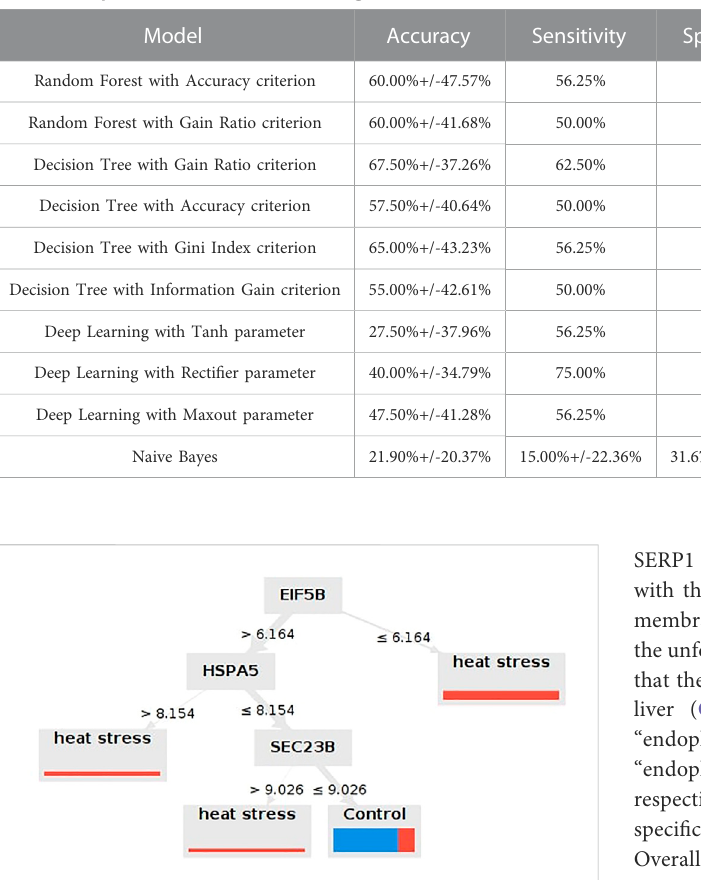
TABLE 4 The performance of machine learning models in acute heat stress in chickens with ten-fold cross validation.